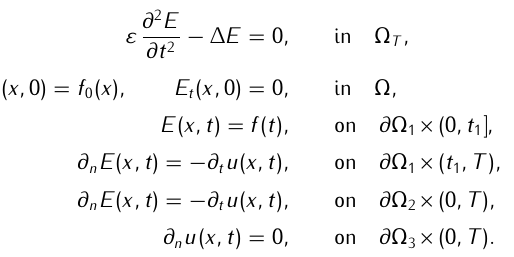
Figure 13. Test 3. Numerical comparisons of the computed L h = 0 . 05 , respectively. We show computed L time steps in T = (0 , 20)